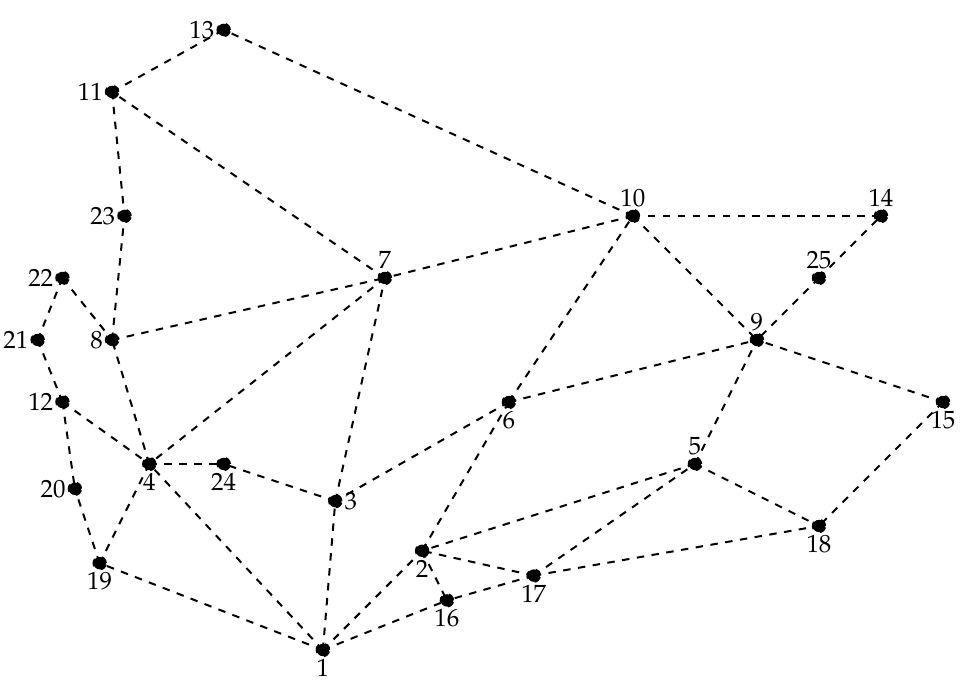
Figure 3. Possible routes of the 25-bus test feeder. Table 6. Information of the possible feeder routes.